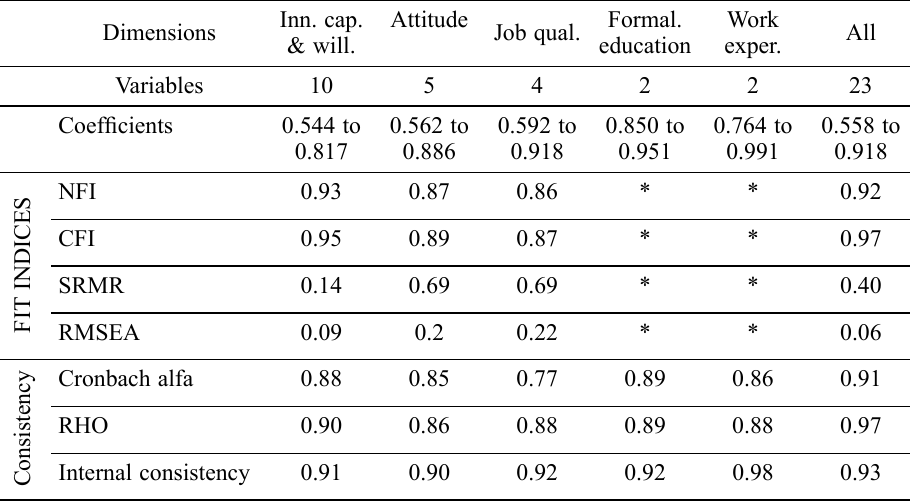
Table 4. The employees’ knowledge